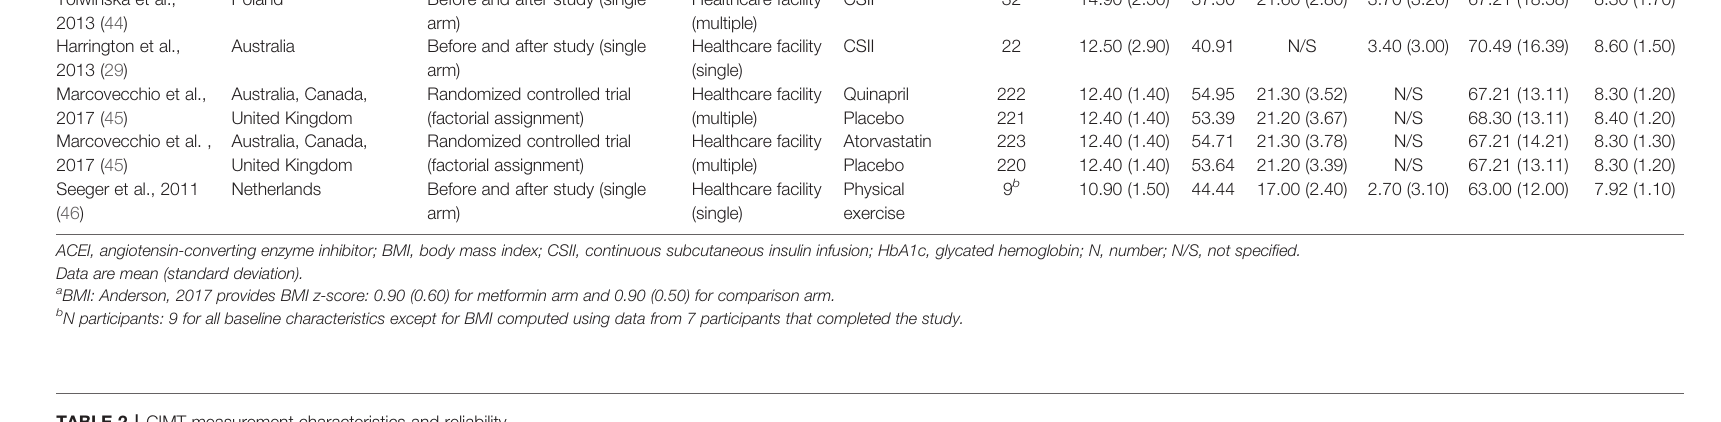
TABLE 2 | CIMT measurement characteristics and